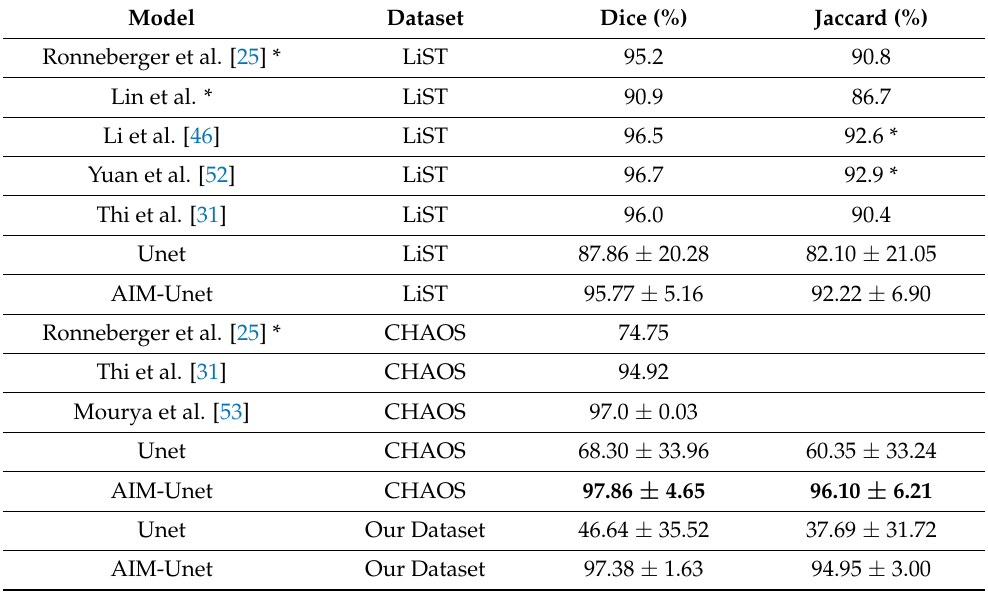
Table 5. The comparison of the proposed method (AIM-Unet) with other state-of-the-art architectures on datasets for liver segmentation.